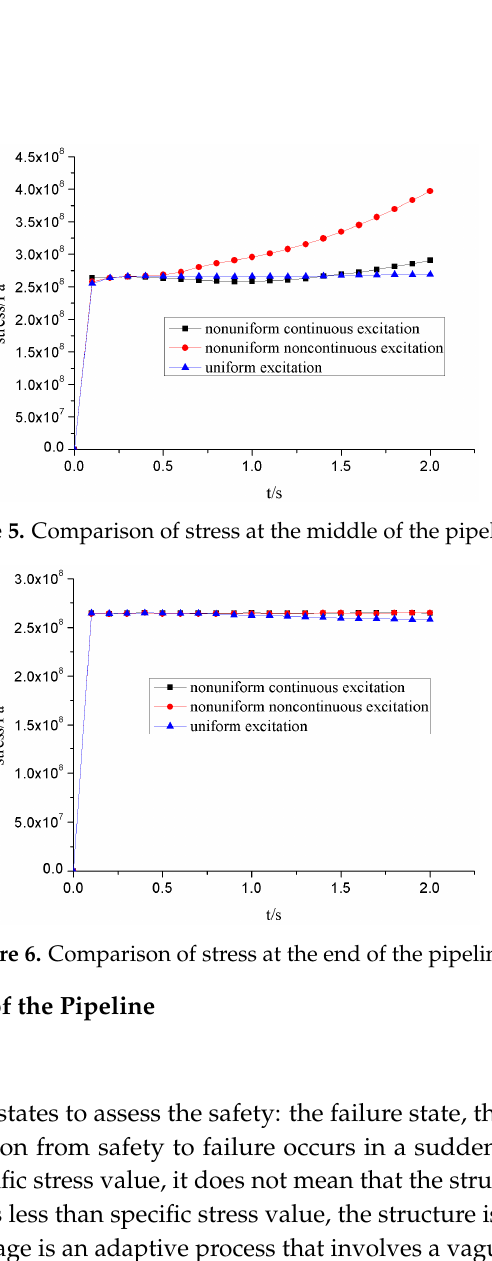
Figure 4. Comparison of the maximum stress point of the pipeline.